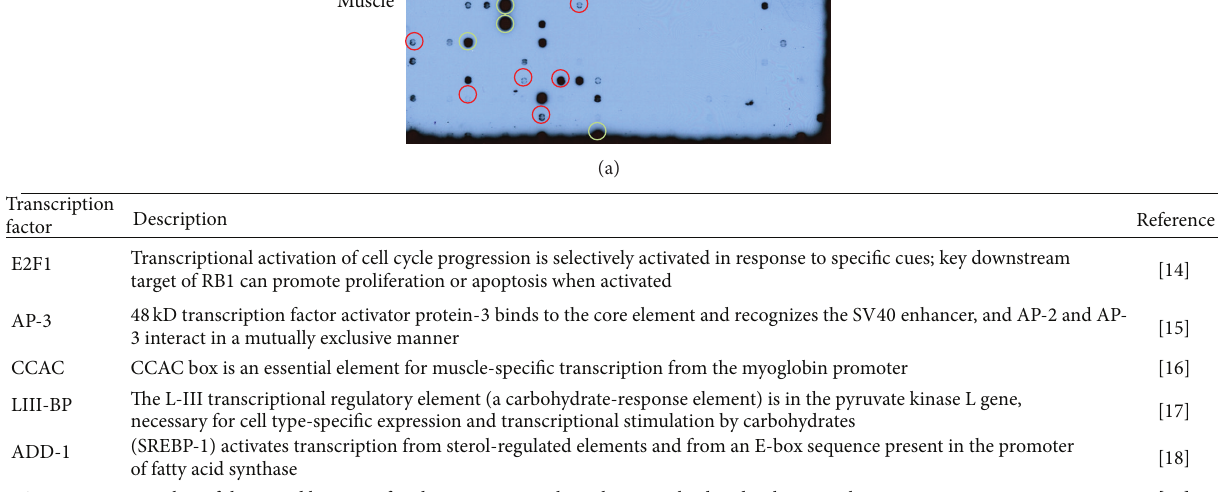
the lack of ABCB1 overexpression, is favorable for avoiding drug